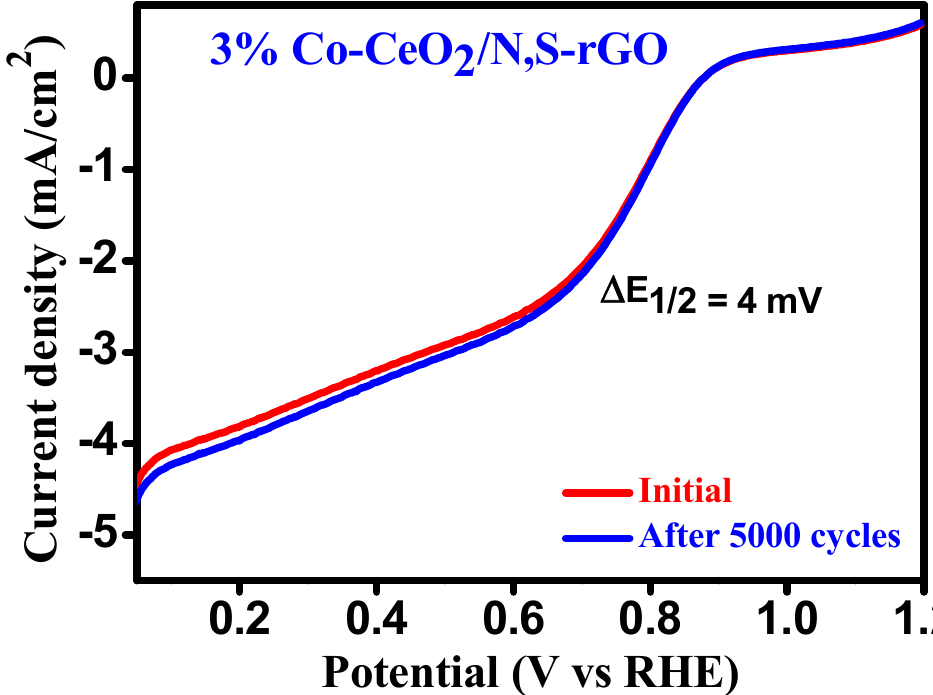
Figure 8. LSV curves of 3% Ce–CeO 2 /N, S–rGO before and after 5000 cycles.